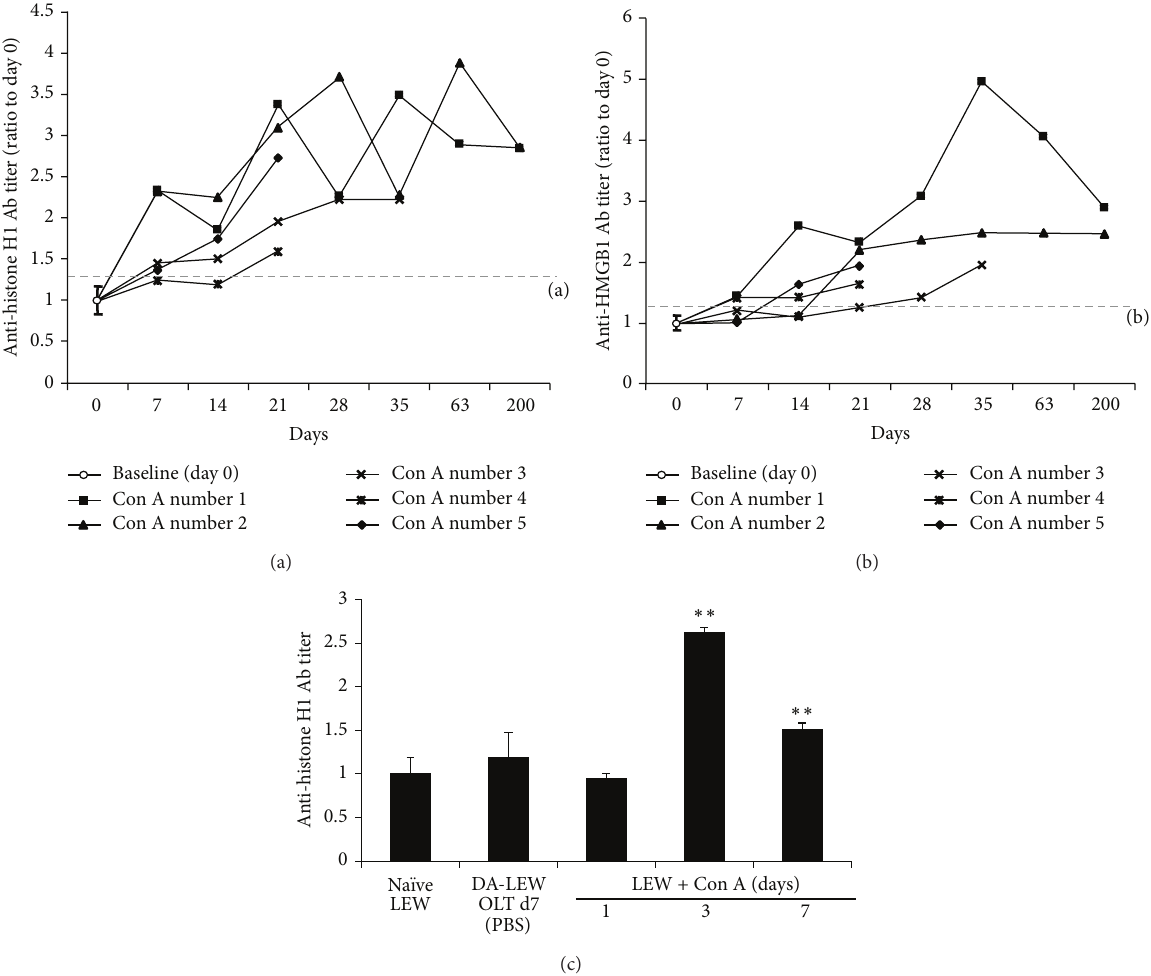
Figure 3: The induction of Ab against nuclear histone H1 (a) and HMGB1 (b) after OLT by the transient induction of de novo autoimmune hepatitis. Anti-histone H1 and HMGB1 Ab titers (optical density at 405 nm) were measured by ELISA as described in the Materials and Methods section. The results are expressed as the mean of three independent experiments (ratio to day 0) ± SD. The dotted line indicates cutoff values ( 𝑃 < 0.05 ) of 2SD above the mean of baseline ( 𝑛 = 15 ) (a: 1.35; b: 1.25). (c) No elevation or transient induction of anti-histone H1 Ab titer was observed in the serum of DA-LEW OLT without Con A injection or nontransplanted LEW rats with Con A injection. The results are expressed as the mean of three independent experiments (ratio to na¨ıve LEW) ± SD. ∗∗ Significantly different compared with the na¨ıve LEW rats ( 𝑛 = 5 ) ( 𝑃 < 0.01 , Student’s t